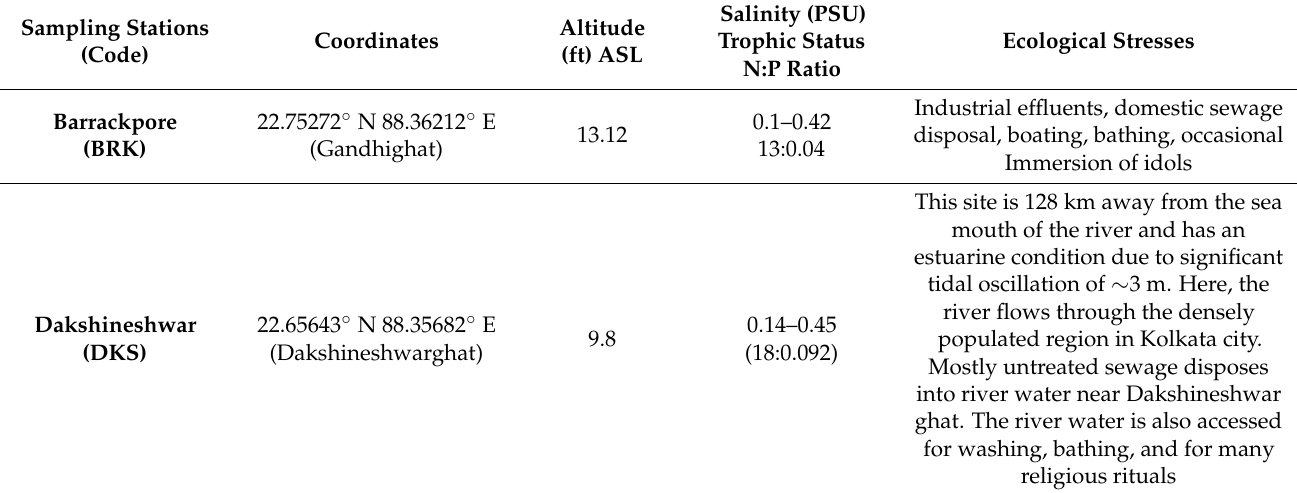
Table 1. Ecological stressors, abbreviations used, and coordinates of the six stations in the HRE sampled during October 2017, February 2018, and June 2018 for the present